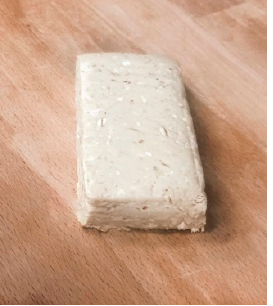
Figure 1. Produced high-protein bar.